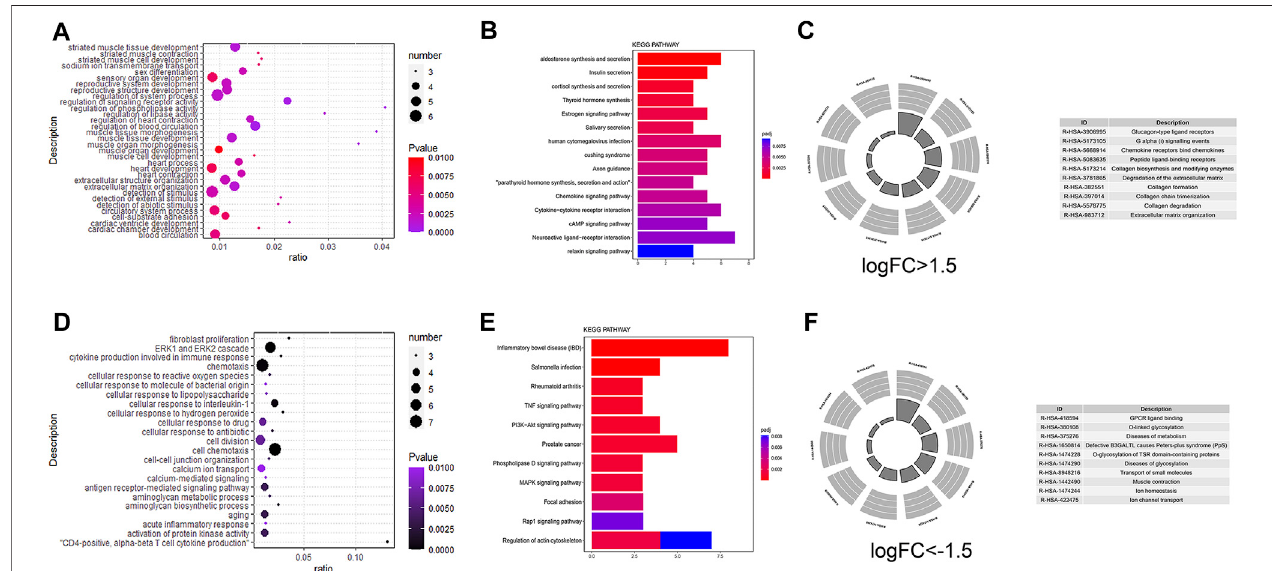
FIGURE 2 | Gene ontology (GO)/Kyoto Encyclopedia of Genes and Genomes (KEGG) pathway enrichment of differential messenger RNA in the dataset. GO pathway enrichment analysis results for differential genes( Figures 2A, D ); KEGG pathway enrichmentresults ( Figures 2B,E ),REACTOMEpathway enrichment results ( Figures 2C, F ); differential genes with logFC > -1.5 ( Figures 2A – C ); differential genes with logFC < − 1.5 differential genes ( Figures 2D – F ).